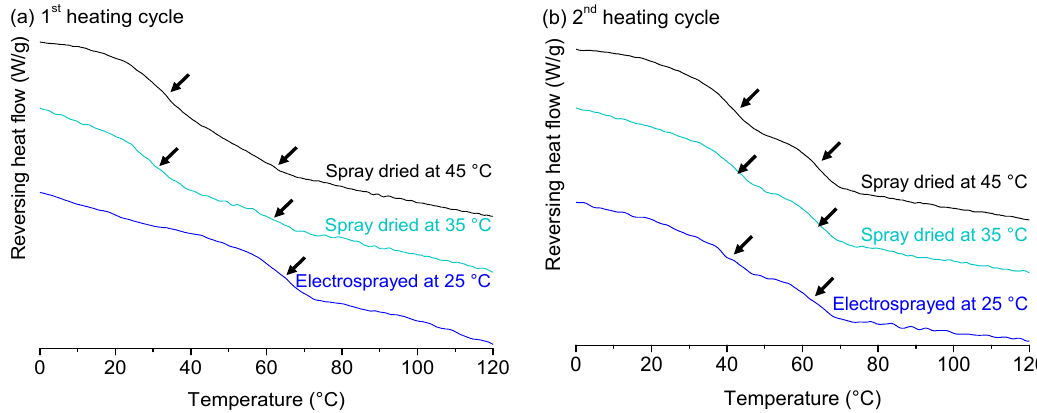
Figure 12. Reversing heat flow, recorded in the first ( a ) and second heating ( b ) cycle of PEtOx/PPrOx (1/1), manufactured via spray drying at 45 °C, at 35 °C and electrospraying at 25 °C. Glass transitions are indicated with arrows in both first (left) and second heating cycle (right). Created with Origin 8.5 from OriginLab (Northampton, MA, USA).